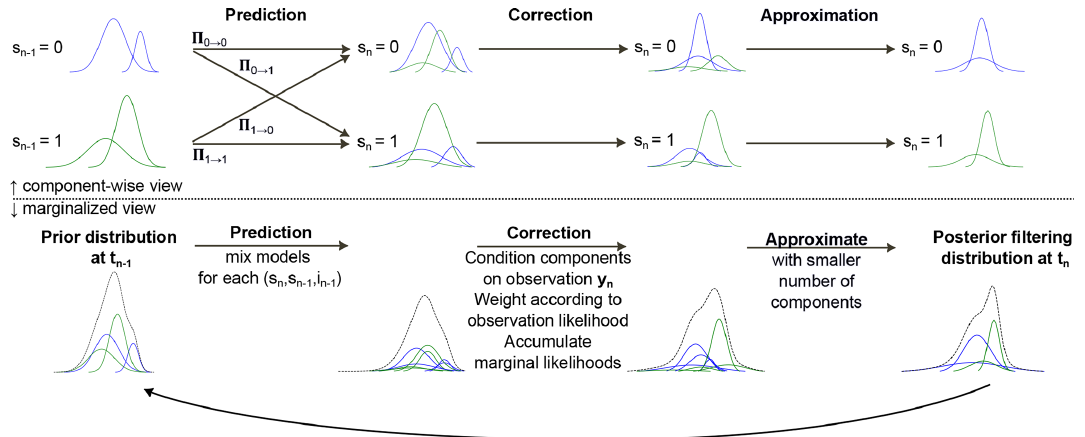
Figure 1. Illustration of the iterative computational methods applied in the Gaussian sum filtering (GSF). The filtering distributions (prior and posterior at time steps t n − 1 and t n , respectively) are displayed as Gaussian mixtures indexed by i n for each of the models indexed by s n . The top panel shows a component-wise view, and the bottom panel shows a marginalized (over s n and i n ) view of the respective compound distributions. The algorithm can be formally divided into the prediction, correction, and approximation steps. The illustrated iteration starts at some specified prior for t 0 . For further details, see text and Appendix A2. The output of the algorithm is the approximated decomposed p (cid:0) s n | y 1 : n (cid:1)(cid:80) i w s p (cid:0) x n | s n ,i n , y 1 : n (cid:1) , the input is a prior and a collection of measurements y 1 : N with associated filtering distribution (cid:80) s n ,i n n n time stamps, measurement times, and values for all parameters (see text). The approximate marginal likelihood of the measurement sequence can be computed alongside the filtering.